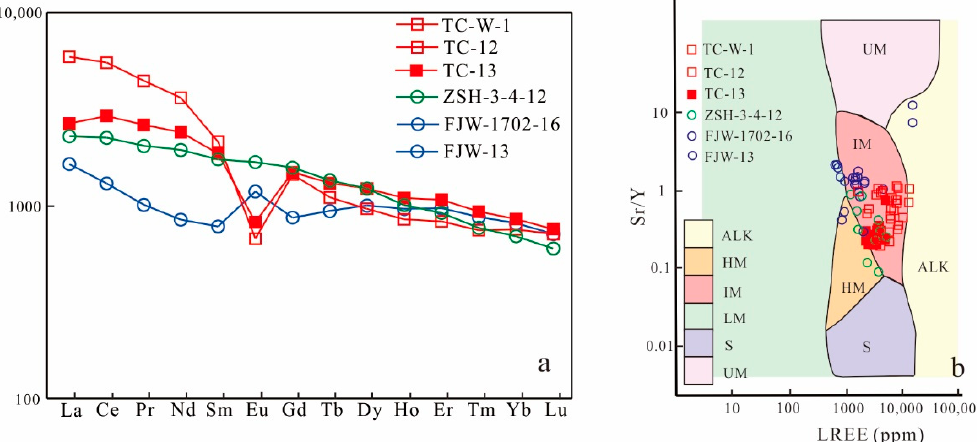
Figure 10. ( a ). The REE patterns of apatite; ( b ). Sr/Y vs. Σ LREE diagram, modified from O’Sullivan [81]. Abbreviations for groups: ALK = alkali-rich igneous rocks; IM = mafic I-type granitoids and mafic igneous rocks; LM = low- and medium-grade metamorphic and metasomatic; HM = partial-melts/leucosomes/high-grade metamorphic; S = S-type granitoids and high aluminum saturation index (ASI) “felsic” I-type; UM = ultramafic rocks including carbonatites, lherzolites, and pyroxe- nites.